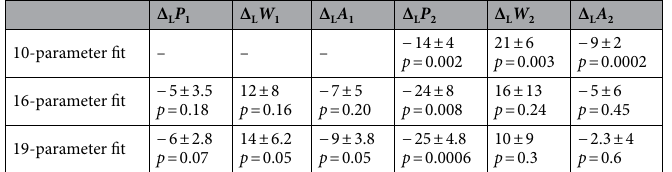
Table 1. Photosensitivity results of fitting the data of Fig. 1a with 10, 16 and 19 parameters. Parameter units as implied by Fig.